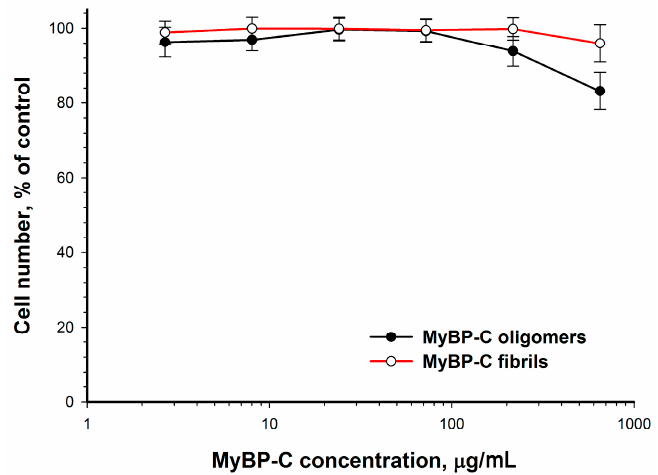
Figure 9. Effect of sMyBP-C aggregates (red graph) and sMyBP-C oligomers (black graph) on rat aortic smooth muscle cells after 72-h incubation.